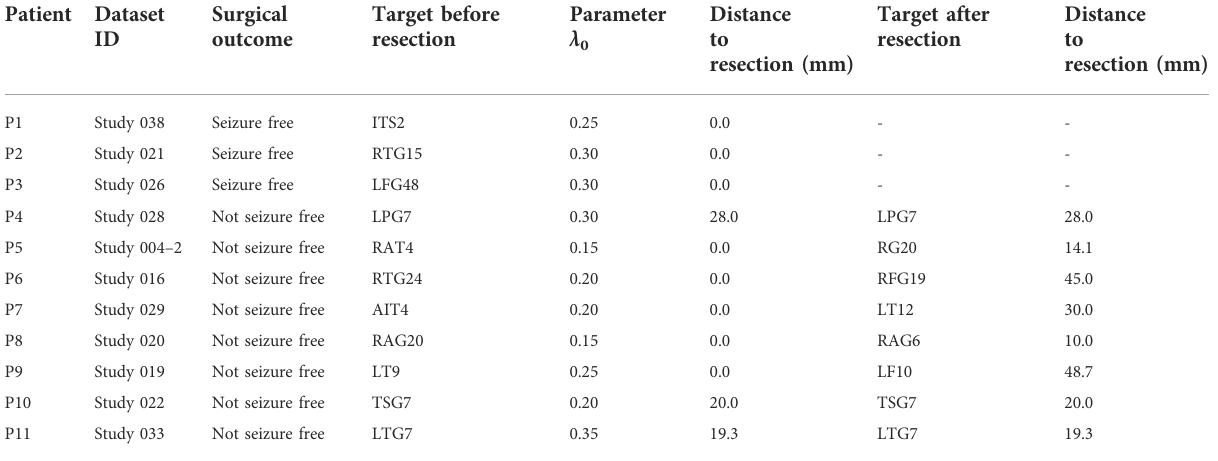
TABLE 1 Patient information, surgical results, optimal parameters, and target location.